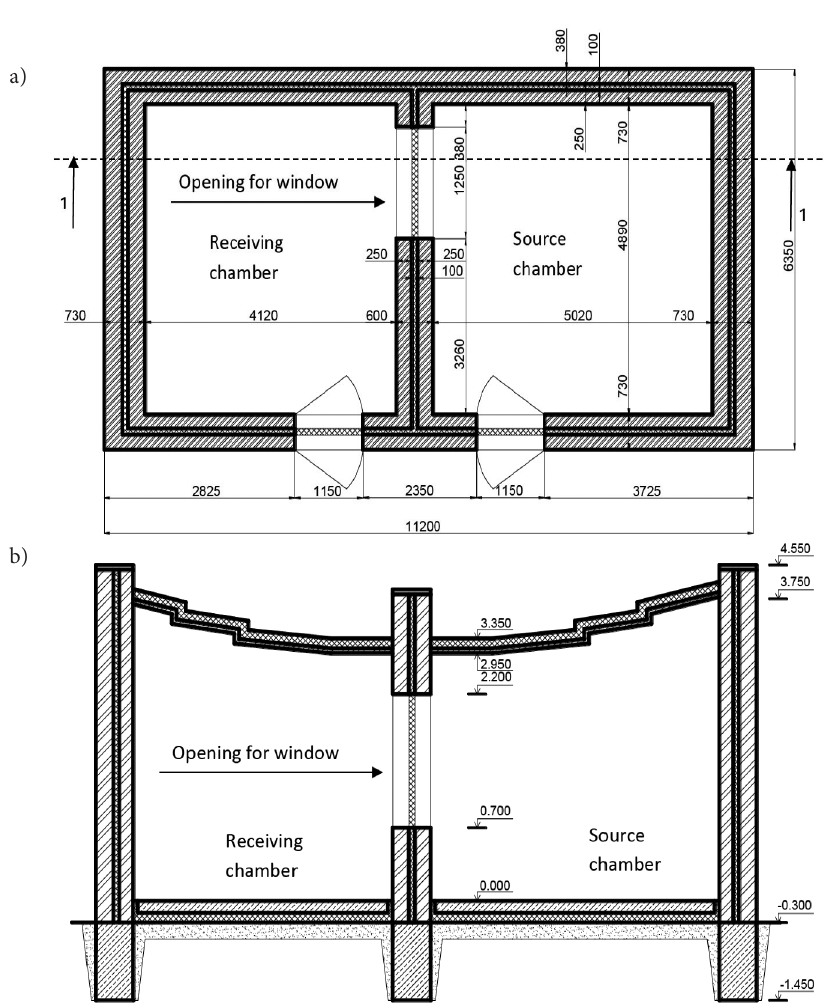
Figure 2. Acoustic test facilities: a) layout; b) vertical cross